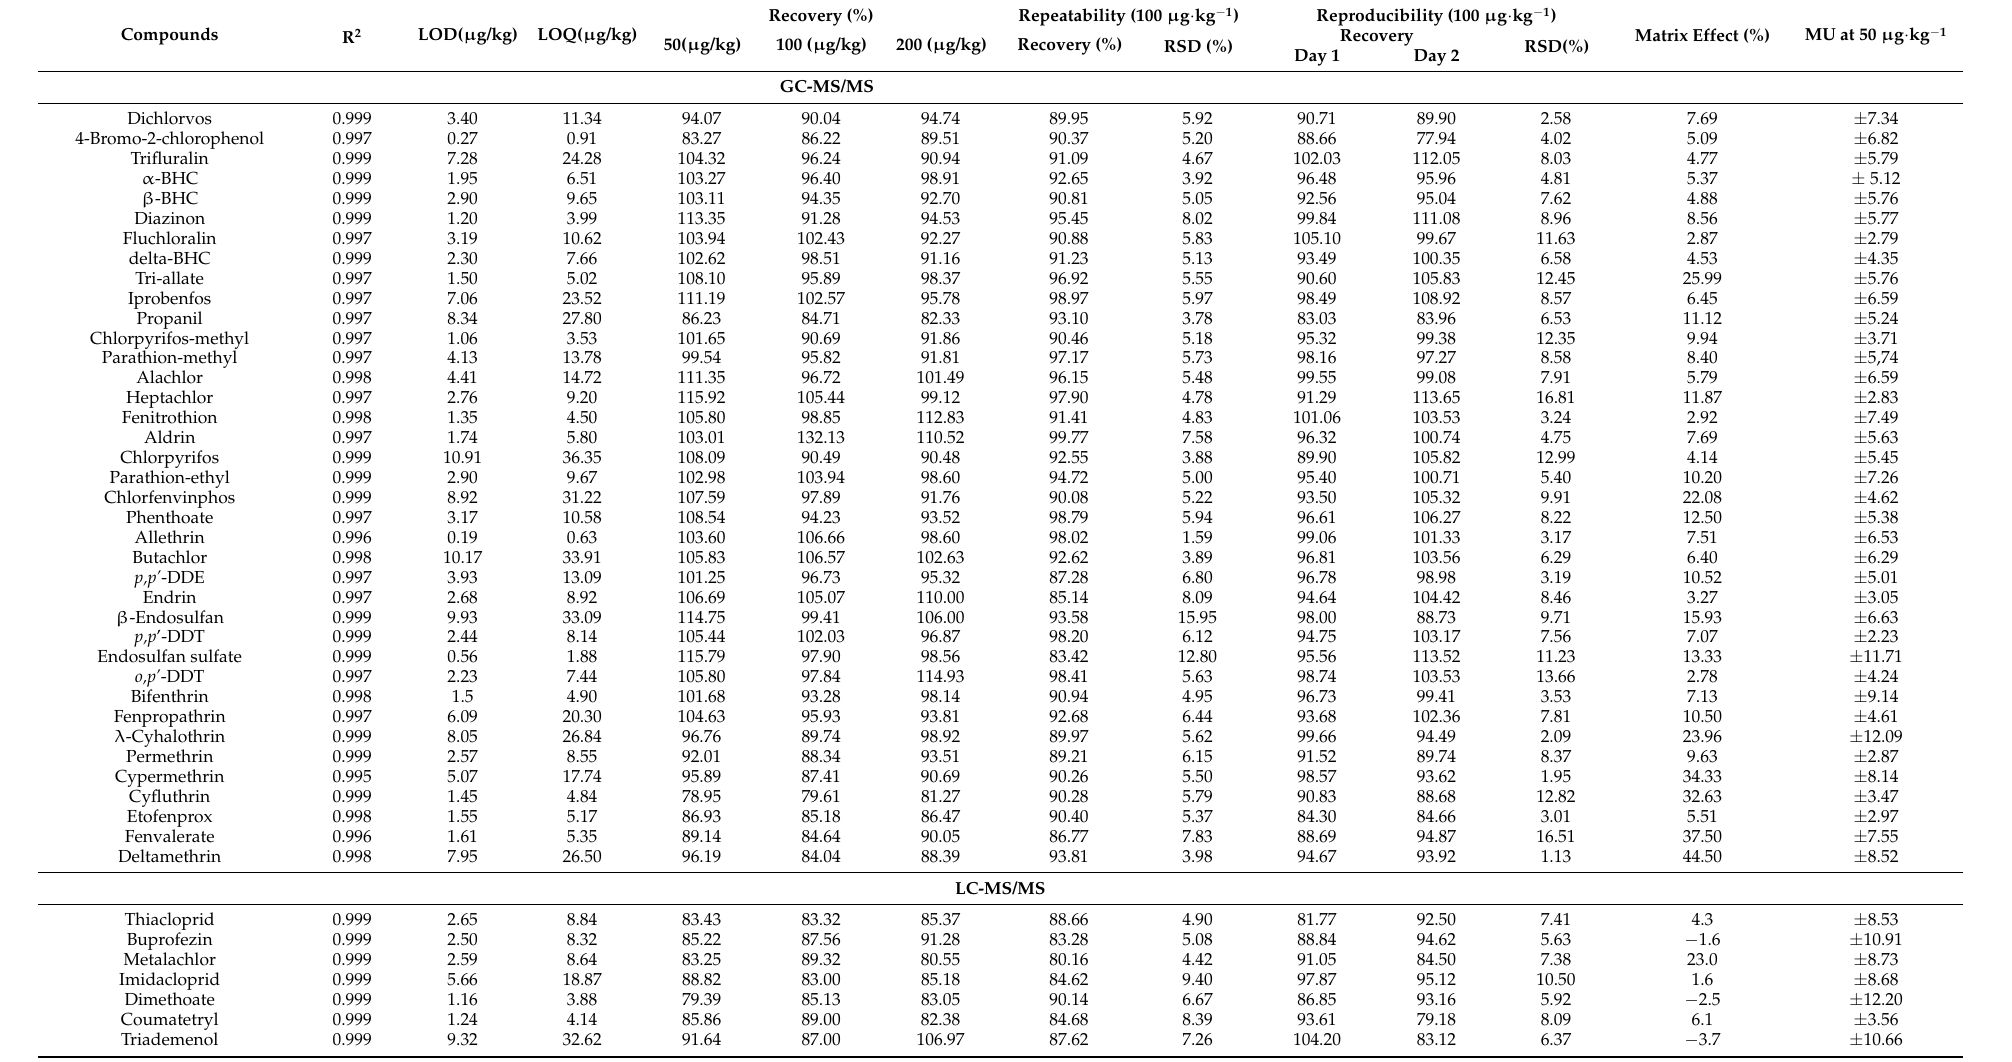
Table 2. Coefficient of determination ( R 2 ), LOD, LOQ, recovery and repeatability of multiclass pesticide analyzed in capsicum using GC-MS/MS and LC-MS/MS.